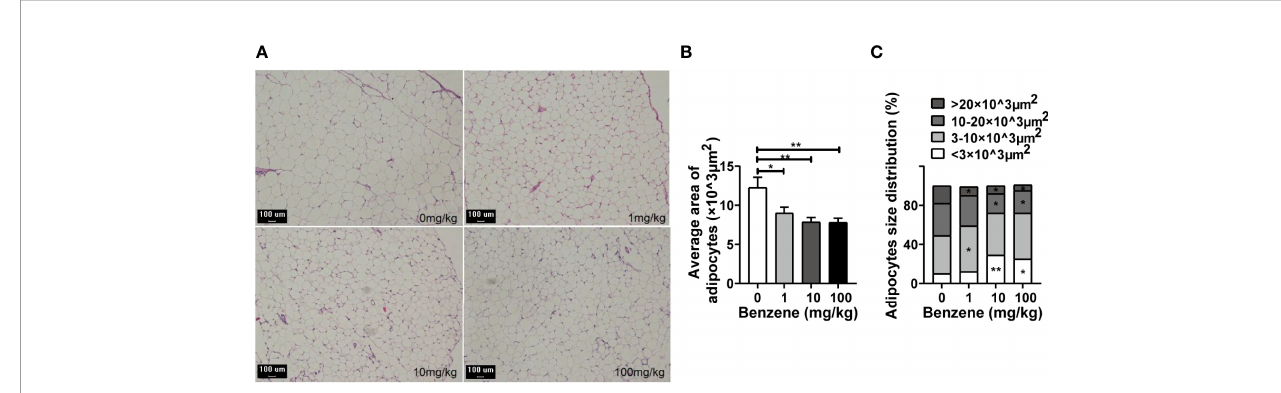
FIGURE 4 | Effect of benzene on epididymal white adipose tissue (eWAT). (A) Representative pictures of the eWAT section with HE staining (100×, bar = 100 m m). The average area of adipocytes of each group (B) and adipocytes size distribution (C) were analyzed. Data are presented as mean ± SD (n = 7-8). One way ANOVA were performed; * p < 0.05, ** p < 0.001 (compared to the control